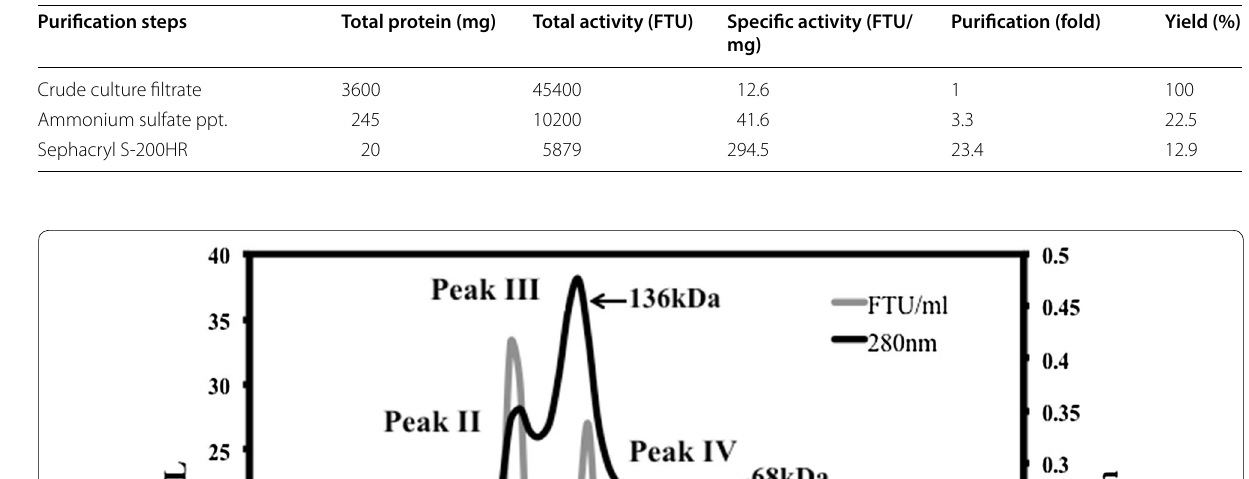
Table 1 Total protein and phytase activities in crude culture filtrate, ammonium sulfate precipitate and column elute showing the increase in specific activities with the fold purification of the enzyme produced by A. foetidus MTCC 11682 strain